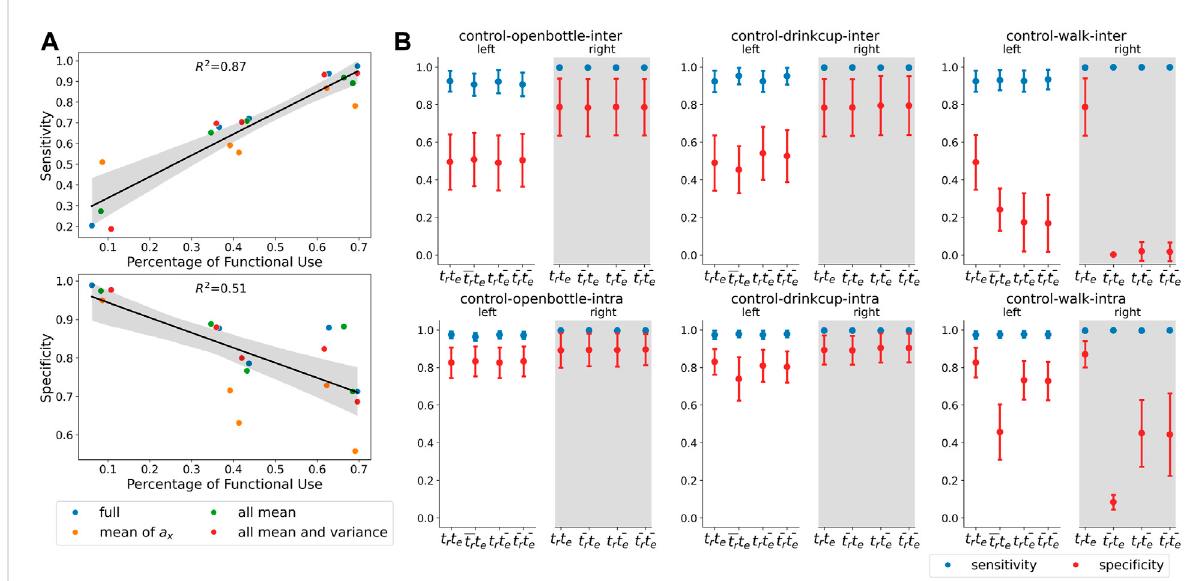
FIGURE 6 (A) Sensitivity and speci fi city obtained from intra-subject RF classi fi ers; ‘ full ’ refers to models trained with all features — mean and variance of a x , ‘ mean of a x ’ are models trained with only the one feature, ‘ all mean ’ a y , a z , mean, variance, maximum, minimum and entropy of (cid:3) a (cid:3) 2 (11 features), referstomodelstrainedwithmeanof a x , a y , a z (3features), ‘ allmeanandvariance ’ aremodelstrainedwithmeanandvarianceof a x , a y , a z (6features), (B) Sensitivity and speci fi city obtained when certain tasks were removed from the train and test sets. Changes in sensitivity were found to be statistically insigni fi cant in all tasks except in intra-subject models for opening bottle task for the left hand (F = 6.05, p = 0.0005). Task labels ‘ openbottle ’ corresponds to ‘ Open a bottle ’ , ‘ drinkcup ’ corresponds to ‘ Drinking from a teacup with handles ’ and ‘ walk ’ corresponds to ‘ Walk 25 m ’ , ‘ Hit a light switch ’ and ‘ Open a door ’